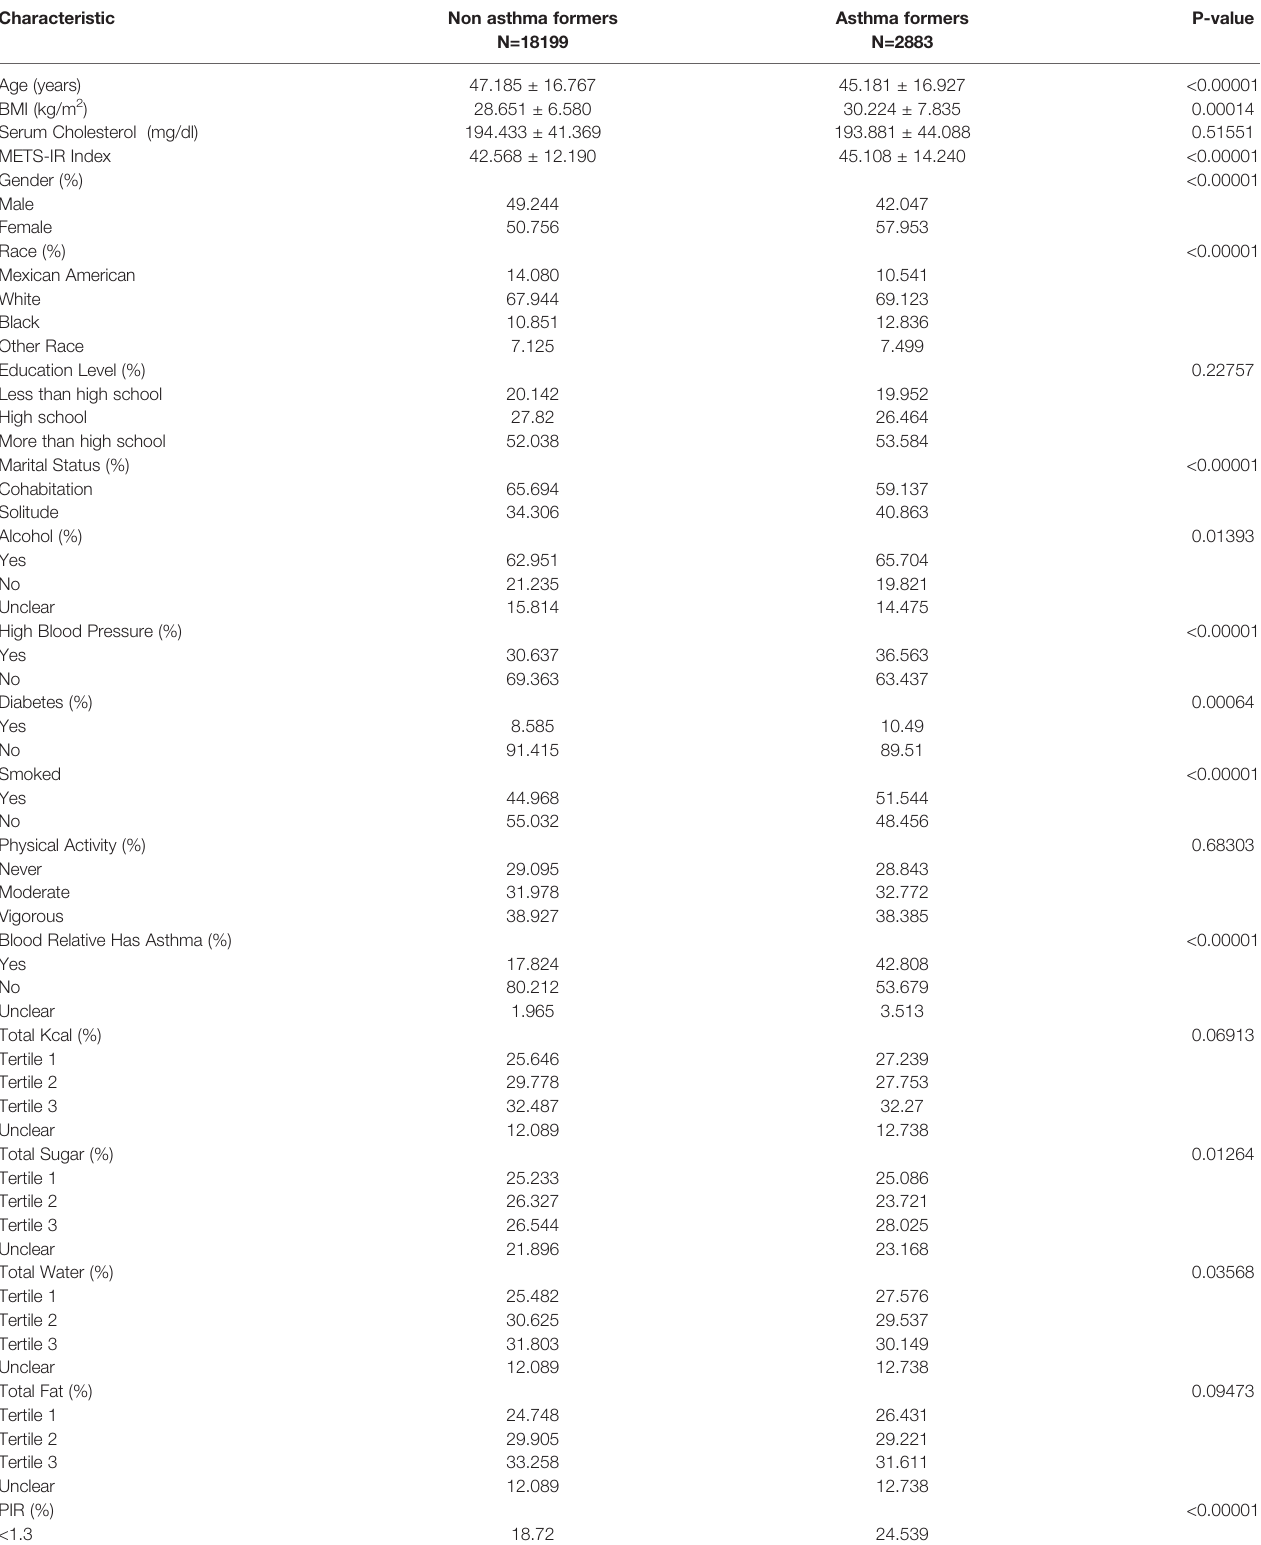
TABLE 1 | Baseline characteristics of participants,